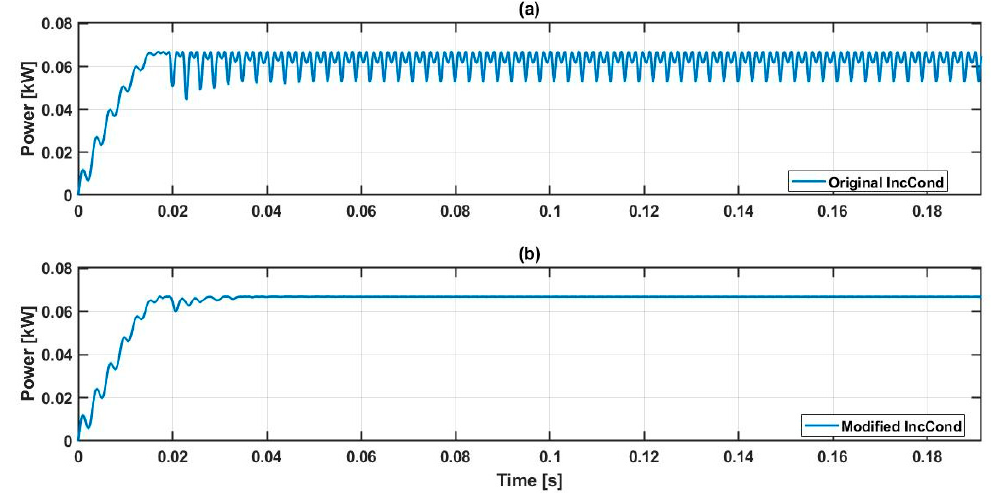
Figure 11. Low-power PV system response time and perturbations: ( a ) original IncCond algorithm and ( b ) modified IncCond algorithm.